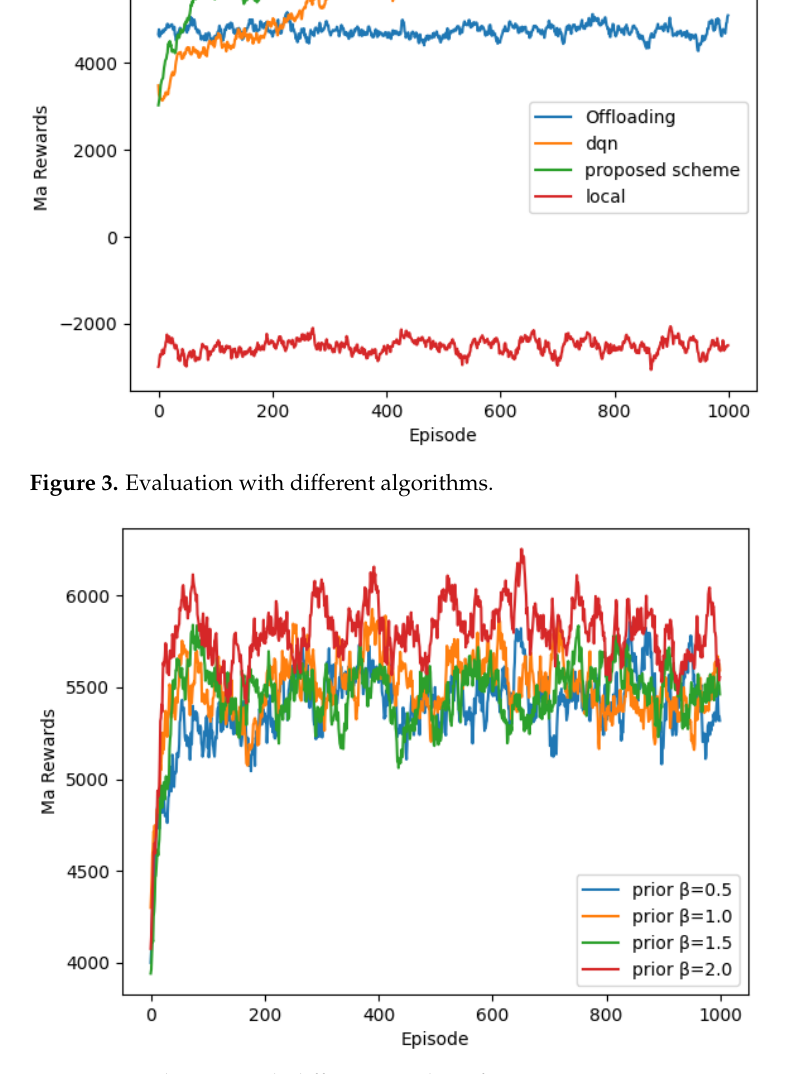
Figure 4. Evaluation with different number of prior β